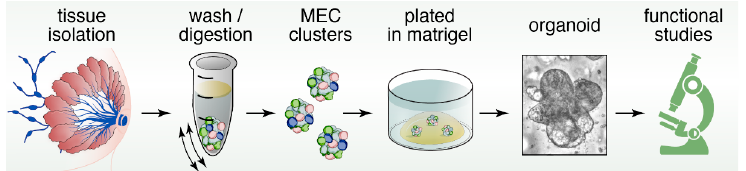
Figure 4. Pipeline of mammary gland organoid cultures. Submerging the Matrigel droplet with growth medium containing Wnt and R-Spondin ligands enables sustained maintenance of stem cell function and allows for functional studies on mammary stem cells (MaSCs) in these 3D cultures.